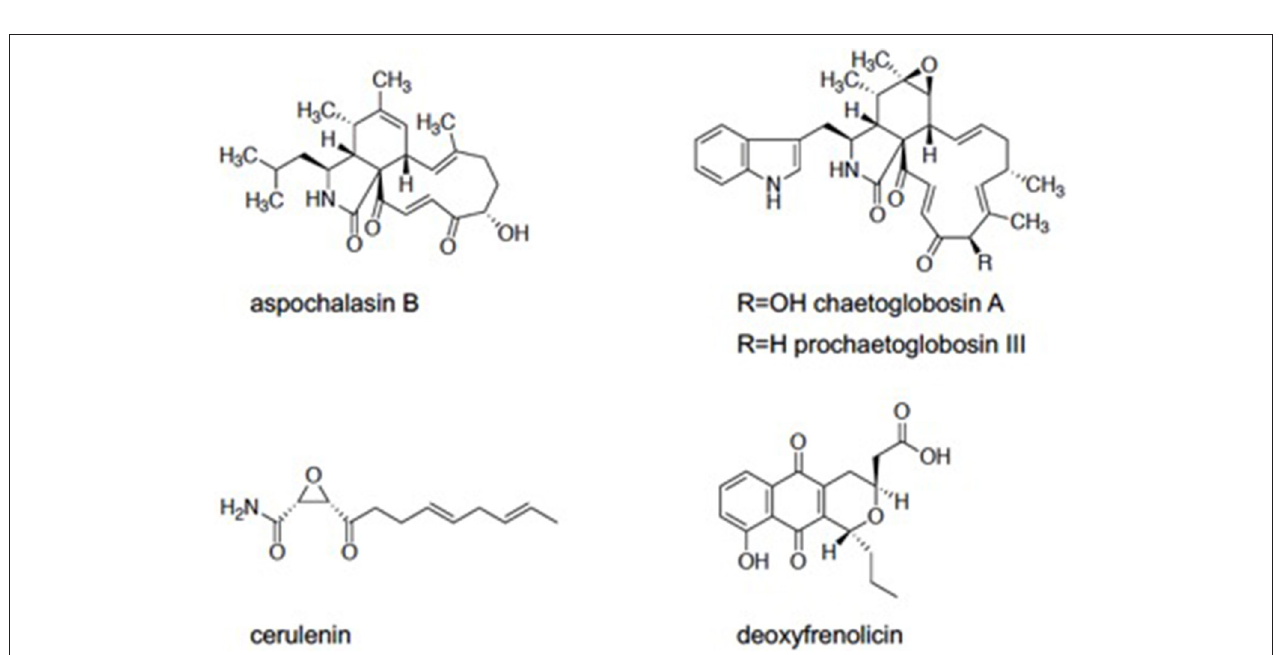
FIGURE 1 | Five compounds which found in Kitasato Natural Products Library.